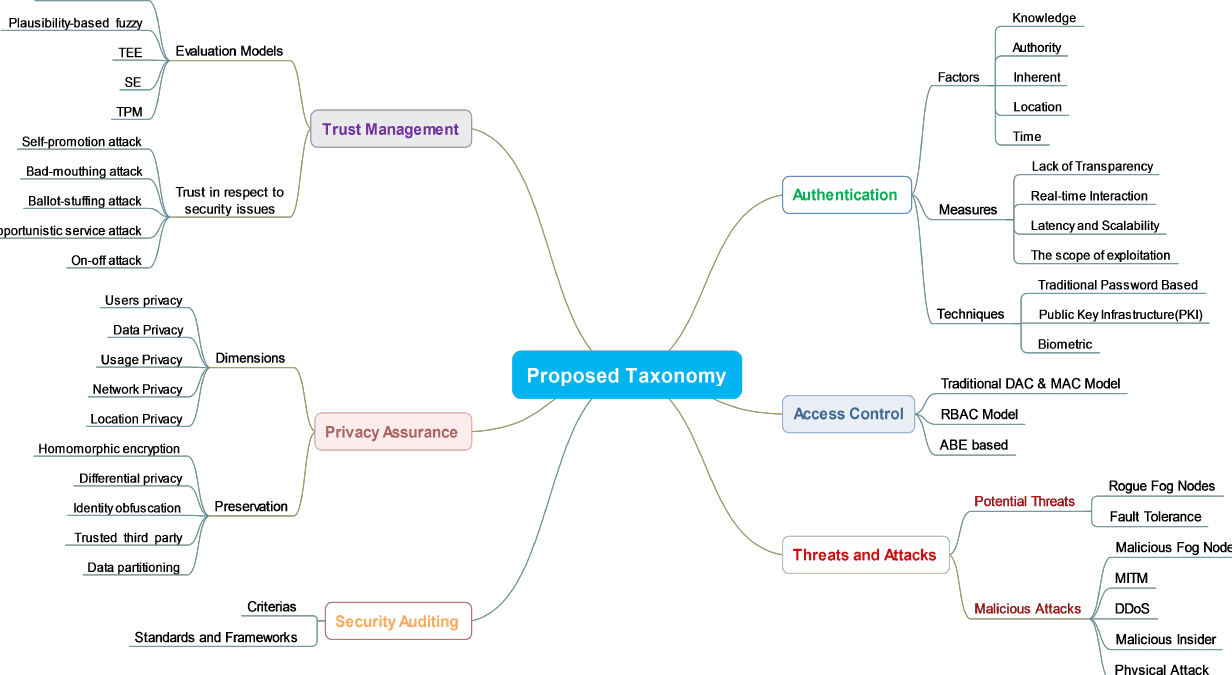
Figure 4. A taxonomy of security issues of fog